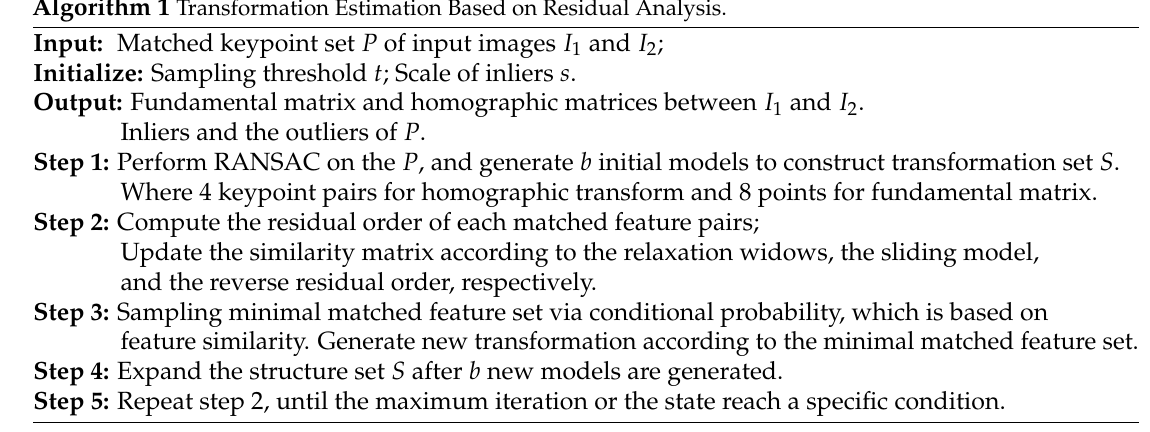
Algorithm 1 Transformation Estimation Based on Residual